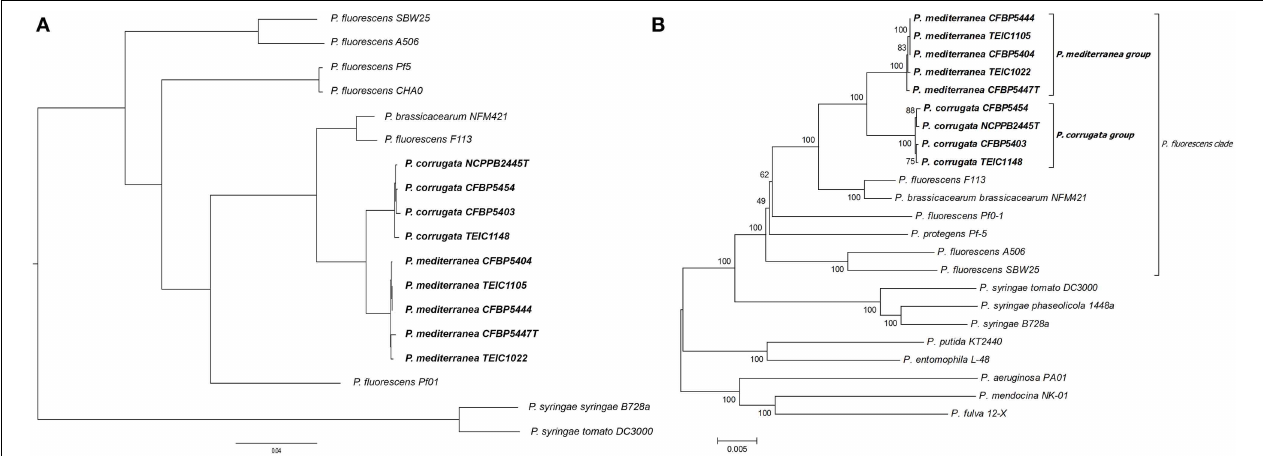
FIGURE 2 | (A) Phylogenetic tree of Pseudomonas species. Prefixes Pcor , Pmed , Pbra, and Pflu correspond to species Pseudomonas corrugata , P. mediterranea , P. brassicacearum , and P. fluorescens , respectively. All nodes had 100% bootstrap support, except the one separating Pmed CFBP5447 and Pmed TEIC1022, with 98% bootstrap support. The tree was generated using whole genome alignment of orthologous proteins following the approach described in Material and Methods, and was drawn using FigTree (http://tree.bio.ed.ac.uk/software/figtree/). (B ) Phylogenetic tree of the examined Pseudomonas strains based on the concatenated partial sequences of fruK , gltA , gyrB , mutL , rpoB , rpoD . Isolate names followed